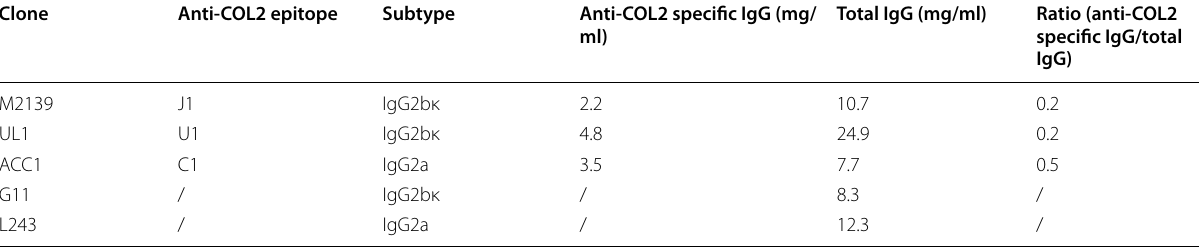
Table 1 Total IgG and anti-COL2 specific IgG concentrations after purification from mouse ascitic fluid Clone Anti-COL2 epitope